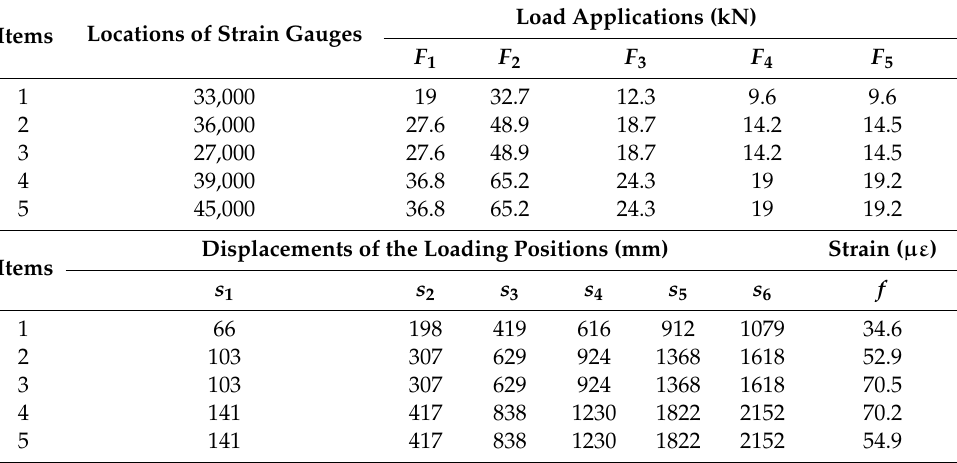
Table 8. The test samples trained by BPNN and PSO-BPNN model.